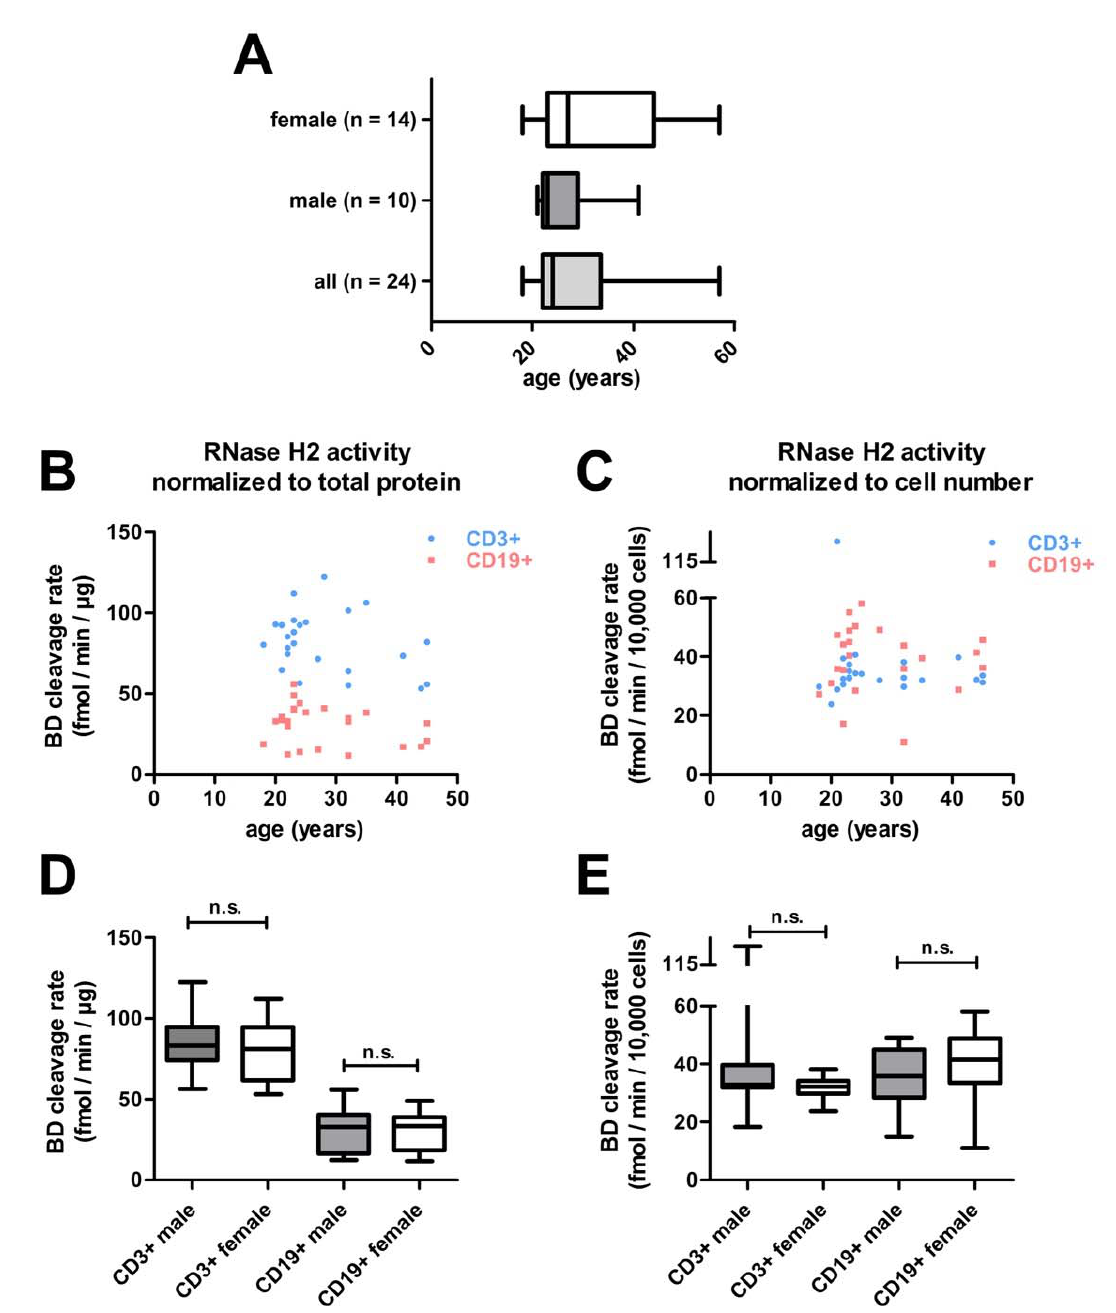
Figure A2. ( A ) Age and gender of the healthy control group (24 individuals with unknown RNASEH2 genotype); ( B , C ) RNaseH2 activity in B and T cells did not correlate with the age of the blood donor when normalized to total protein ( B ) (spearman r (T cells) = − 0.16; r (B cells) = − 0.16) or cell number ( C ) (spearman r (T cells) = − 0.16; r (B cells) = − 0.16); ( D , E ) substrate BD cleavage rates normalized to total cellular protein ( D ) or cell number ( E ) in B and T cells from males ( n = 10) and females ( n =14) are shown. Two-tailed unpaired t-testing did not show any significant difference between male and female probands, neither with normalization to cell number (p (T cells) = 0.85 and p (B cells) = 0.36), nor with normalization to total protein (p (T cells) = 0.46 and p (B cells) = 0.89). Median is shown, boxes indicate 25th and 75th percentile, and whiskers indicate minimum and